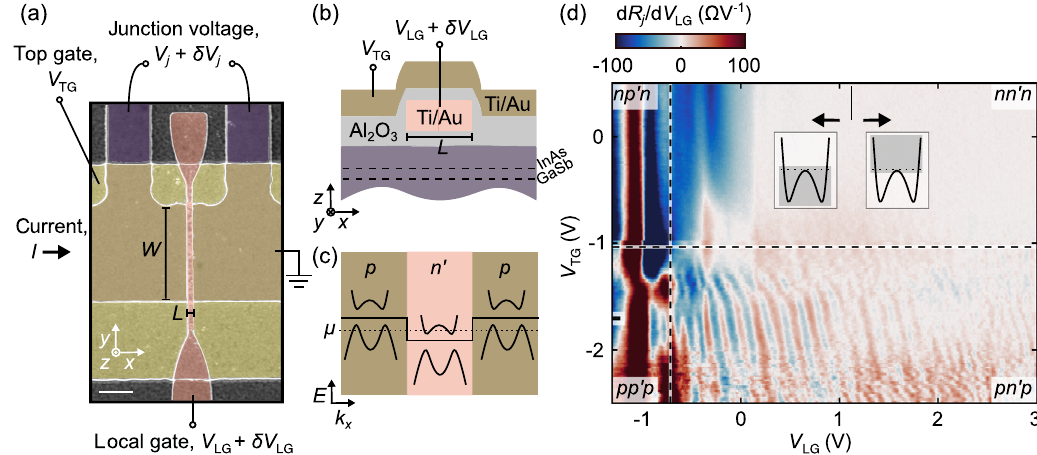
FIG. 1. (a) False-color image describing the device structure and operation. The scale bar represents 2 μ m. (b) Schematic device cross section. (c) Exemplary band alignment E ð k Þ in the pn 0 p configuration; μ is the electrochemical potential, indicated by the dotted line, and the solid line indicates the charge neutrality point (CNP) in each region. (d) Color map depicting the differential junction resistance dR =dV as a function of V and V at 1.3 K. The resulting phase diagram is subdivided into quadrants according to the charge- j LG LG TG carrier configuration. The horizontal and vertical dashed lines mark the CNPs of the leads and the cavity, respectively. The insets show 1 . 1 V in the pn 0 p configuration, as highlighted by the parts of the band structure probed to the left and right of the solid line at V LG ¼ the